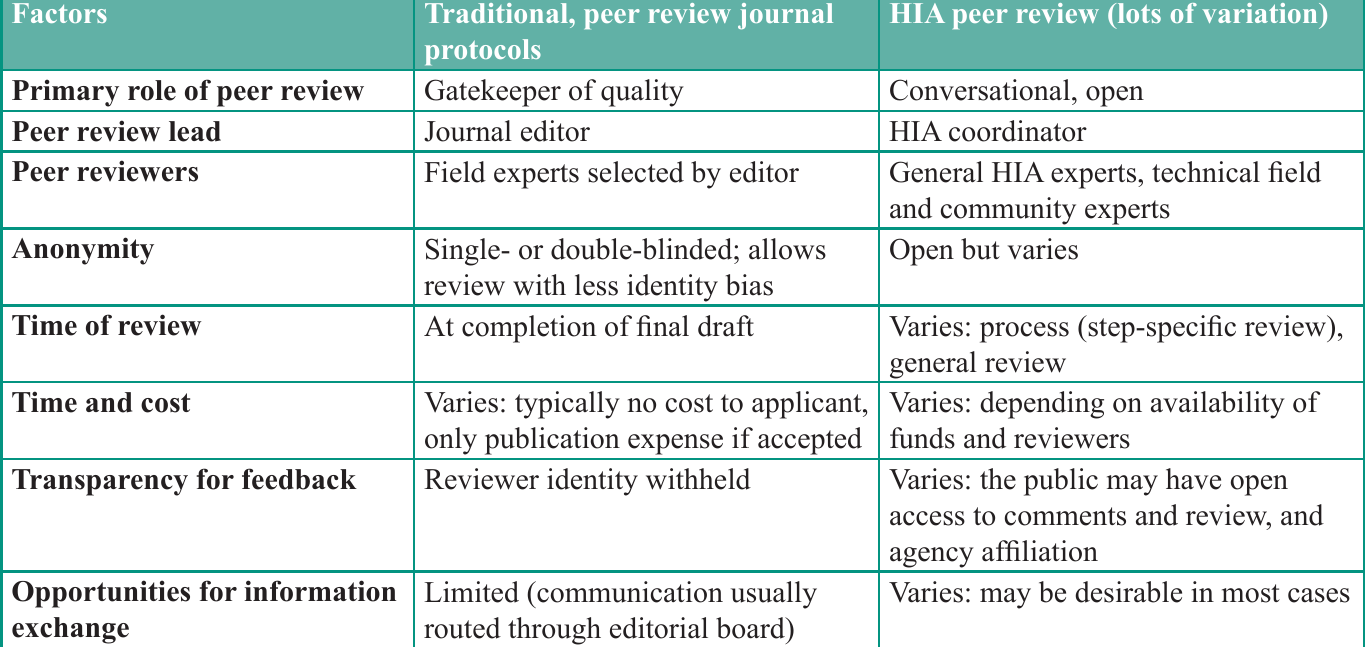
Table 4: Comparison of Peer Review Factors for Traditional Journal Articles and HIA